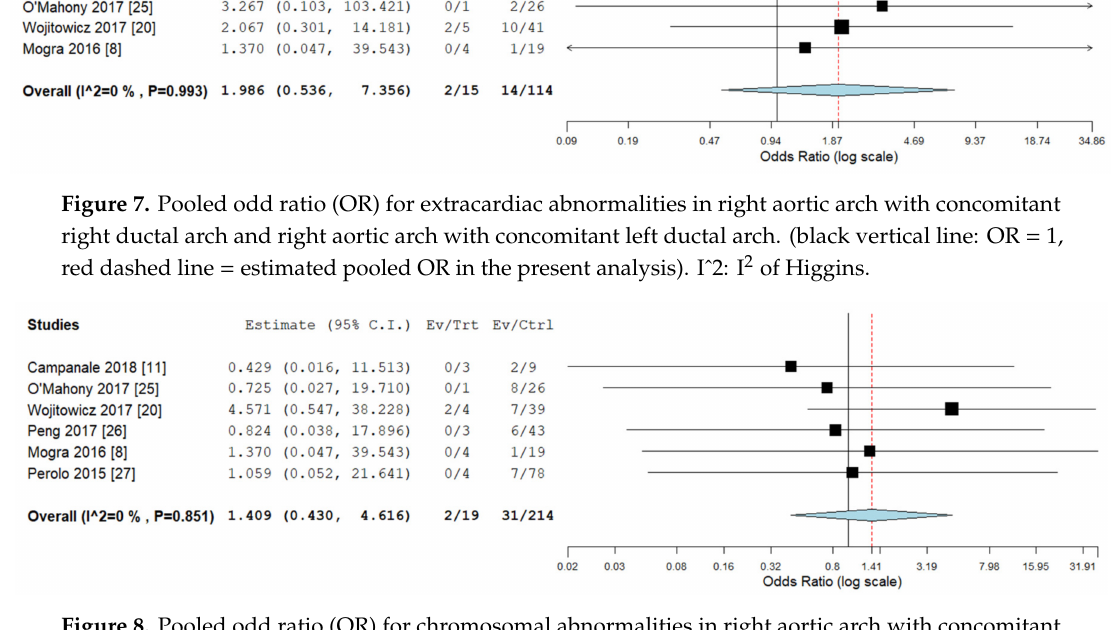
Figure 8. Pooled odd ratio (OR) for chromosomal abnormalities in right aortic arch with concomitant right ductal arch and right aortic arch with concomitant left ductal arch. (black vertical line: OR = 1, red dashed line = estimated pooled OR in the present analysis). Iˆ2: I 2 of Higgins.